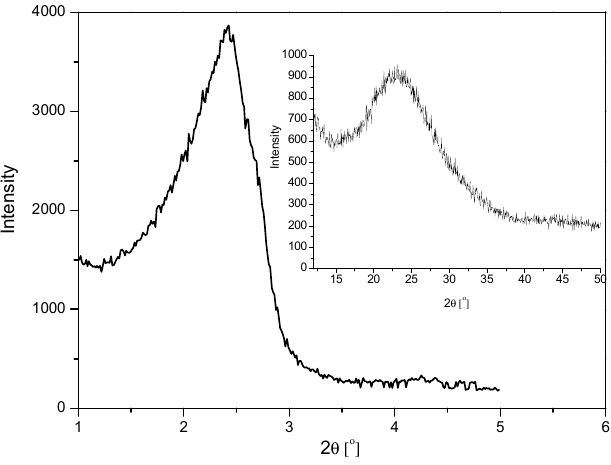
Figure 6. XRD diffraction patterns of Ti-MCM-41.